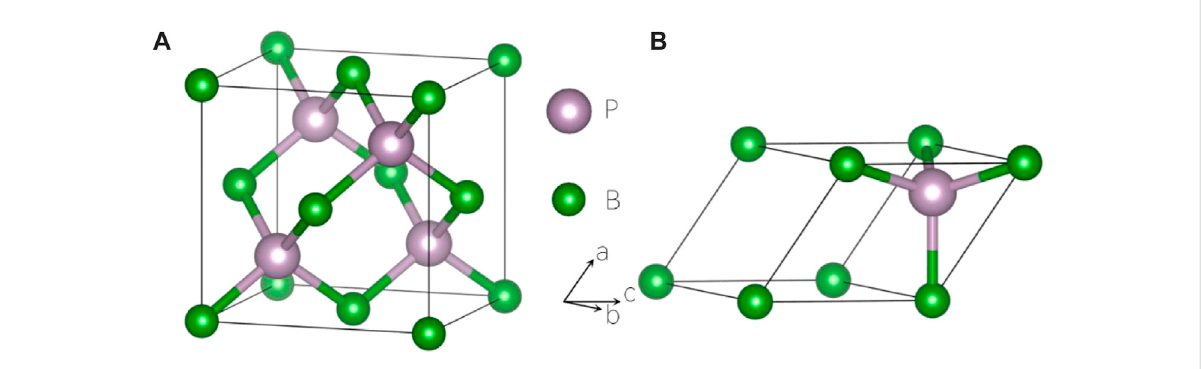
FIGURE 1 (A,B) crystal structure of unit cell and primitive cell of